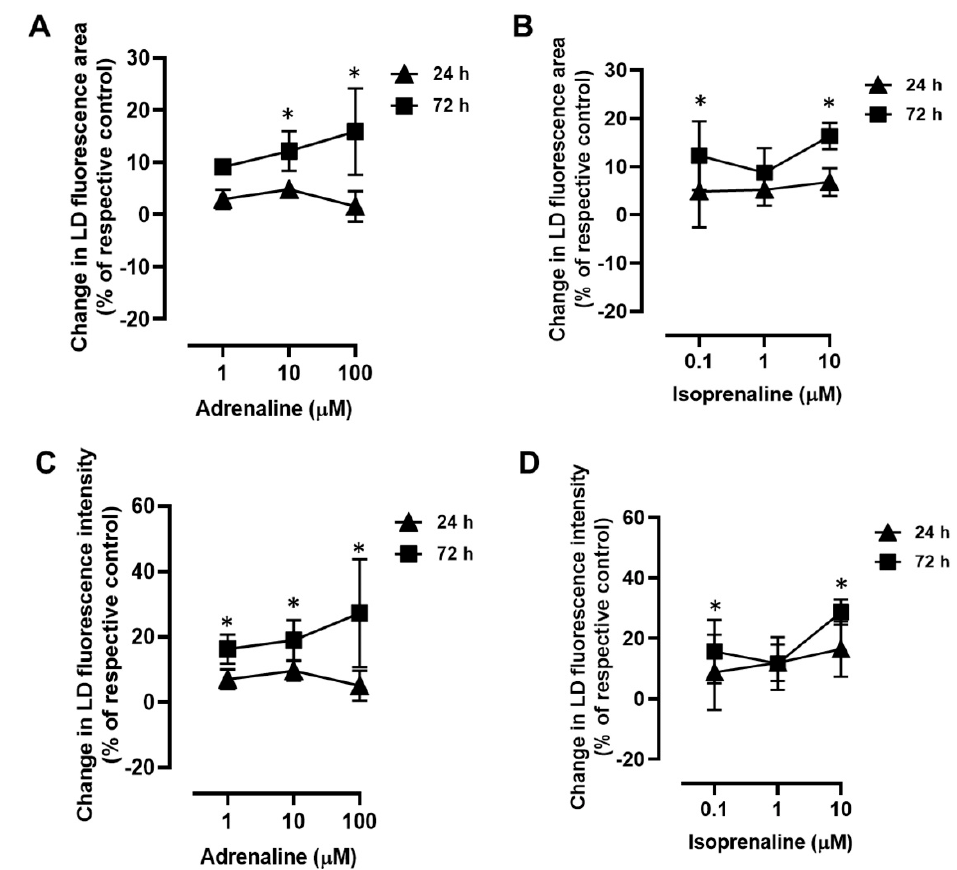
Figure 2. Influence of β -adrenoceptor activation in lipid droplet (LD) area ( A , B ) and Nile Red fluorescence intensity ( C , D ) in MCF-7 breast cancer cells. Cells were treated with either ( A , C ) the non-selective adrenoceptor agonist adrenaline (1–100 µ M) or ( B , D ) the non-selective β -adrenoceptor agonist isoprenaline (0.1 − 10 µ M) for 24 h and 72 h. Results shown are a percentage of change in LD area or in LD fluorescence intensity compared to control (solvent) and are presented as mean ± SD from 4 − 5 independent experiments. * p < 0.05, significantly different from solvent, one-way ANOVA, post hoc multi-comparisons Dunnett’s test.